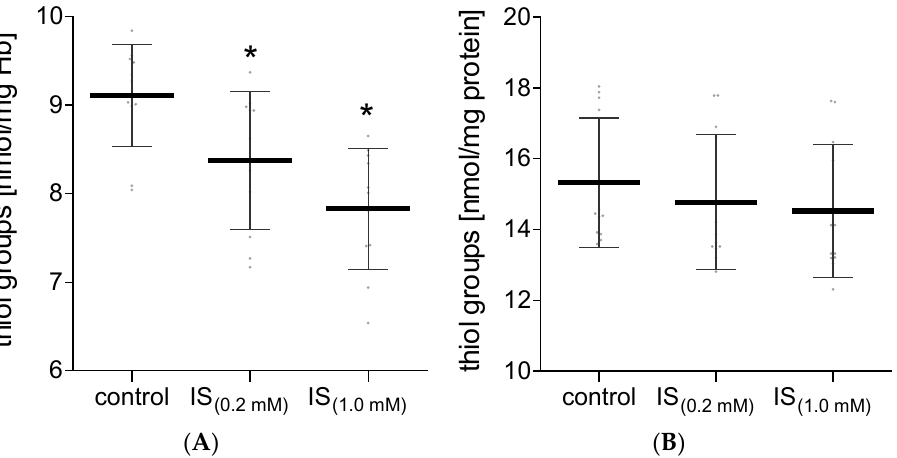
Figure 3. The levels of the free thiol groups in hemolysate ( A ) and plasma ( B ) after incubation with IS. Data are expressed as mean ± standard deviation, n = 12, * p < 0.05—IS (0.2 mM) and IS (1.0 mM) vs. control. Gray spots: values of single results.